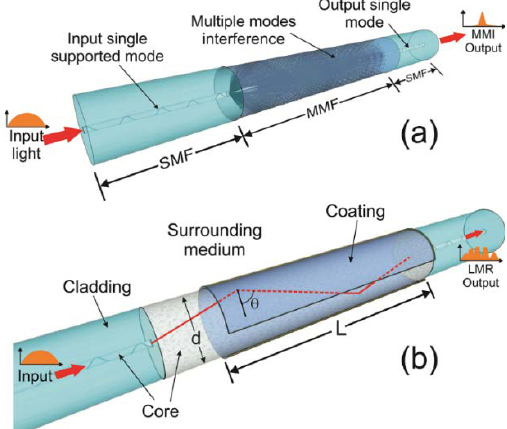
Figure 1. Schematic of the single-mode–multimode–single-mode (SMS) fiber structure: ( a ) without coating (multimode interference effect), and ( b ) with a sensitive region L from the thin film coating (lossy mode resonance (LMR) phenomenon).